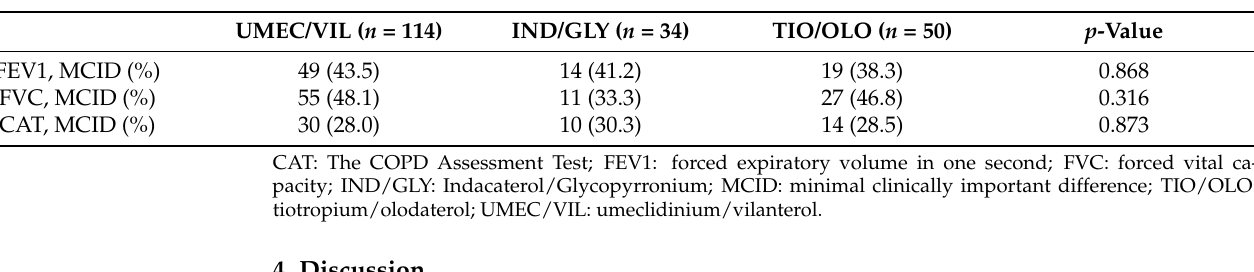
Figure 4. The significant difference in RV (%) in COPD patients before and after 12 months of treatment with ( A ) UMEC/VIL, ( B ) IND/GLY, and ( C ) TIO/OLO. Data were presented as mean and standard deviation.